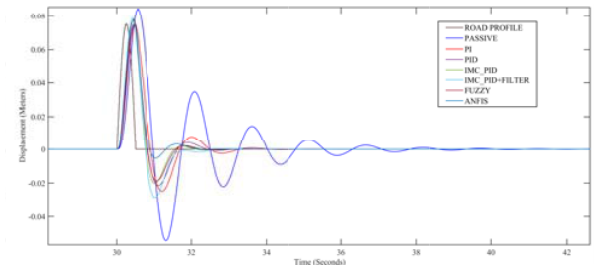
Figure 14. Response against Road profile 1b